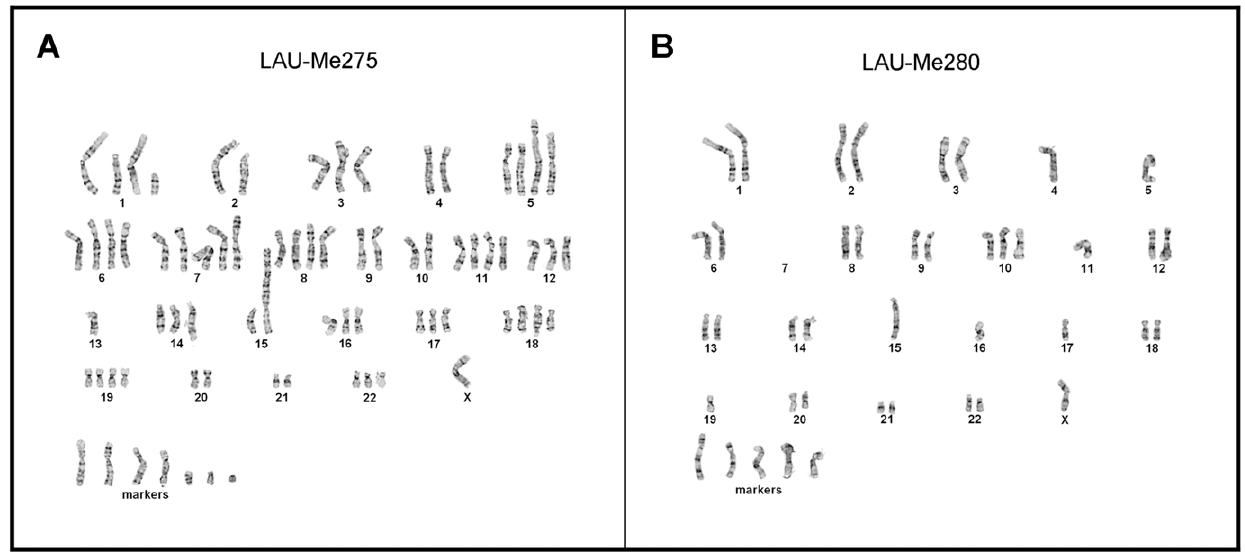
Figure 1. Karyotypes of two malignant melanomas. Representative karyotype (Giemsa stain) for LAU-Me275, one of the most hyperploid melanoma (here 76 chromosomes including 7 markers); and LAU-Me280, the most extensively deleted line (42 chromosomes including 5 markers).